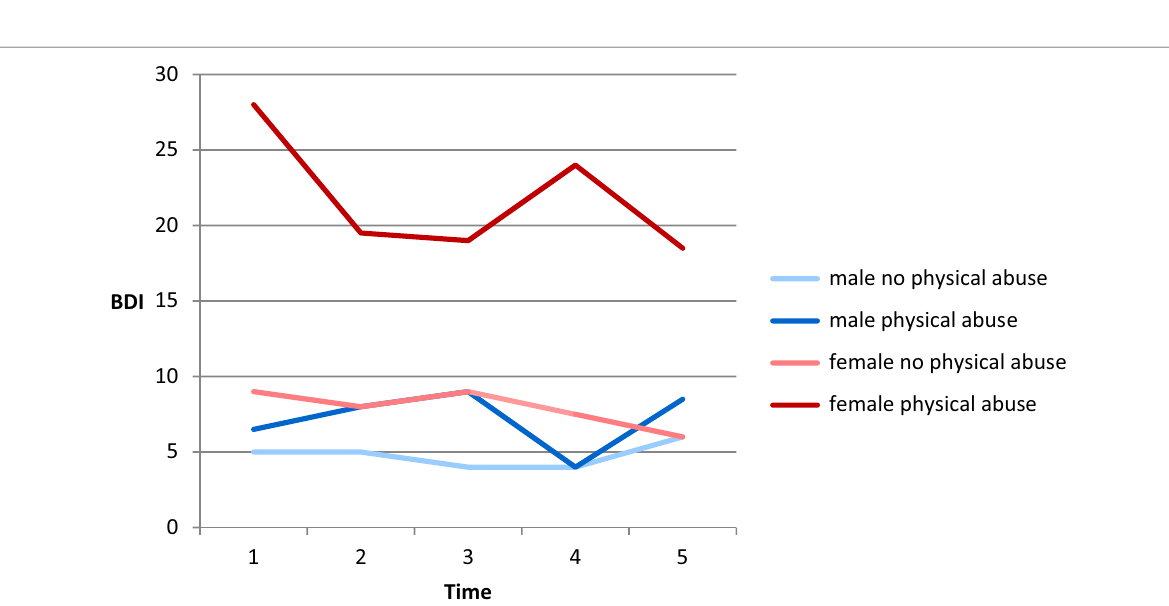
Fig. 2 Course of depressive symptoms from Time 1 to Time 5 for men and women with and without experiences of physical abuse. BDI Beck Depression